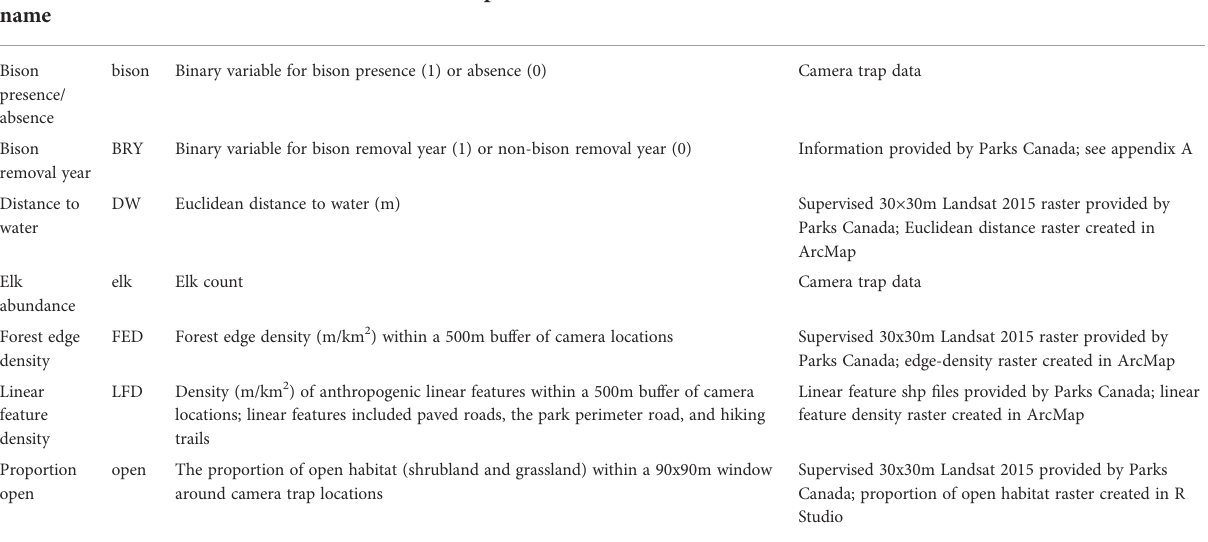
TABLE 1 Descriptions of covariates used in bison and elk generalized linear models.